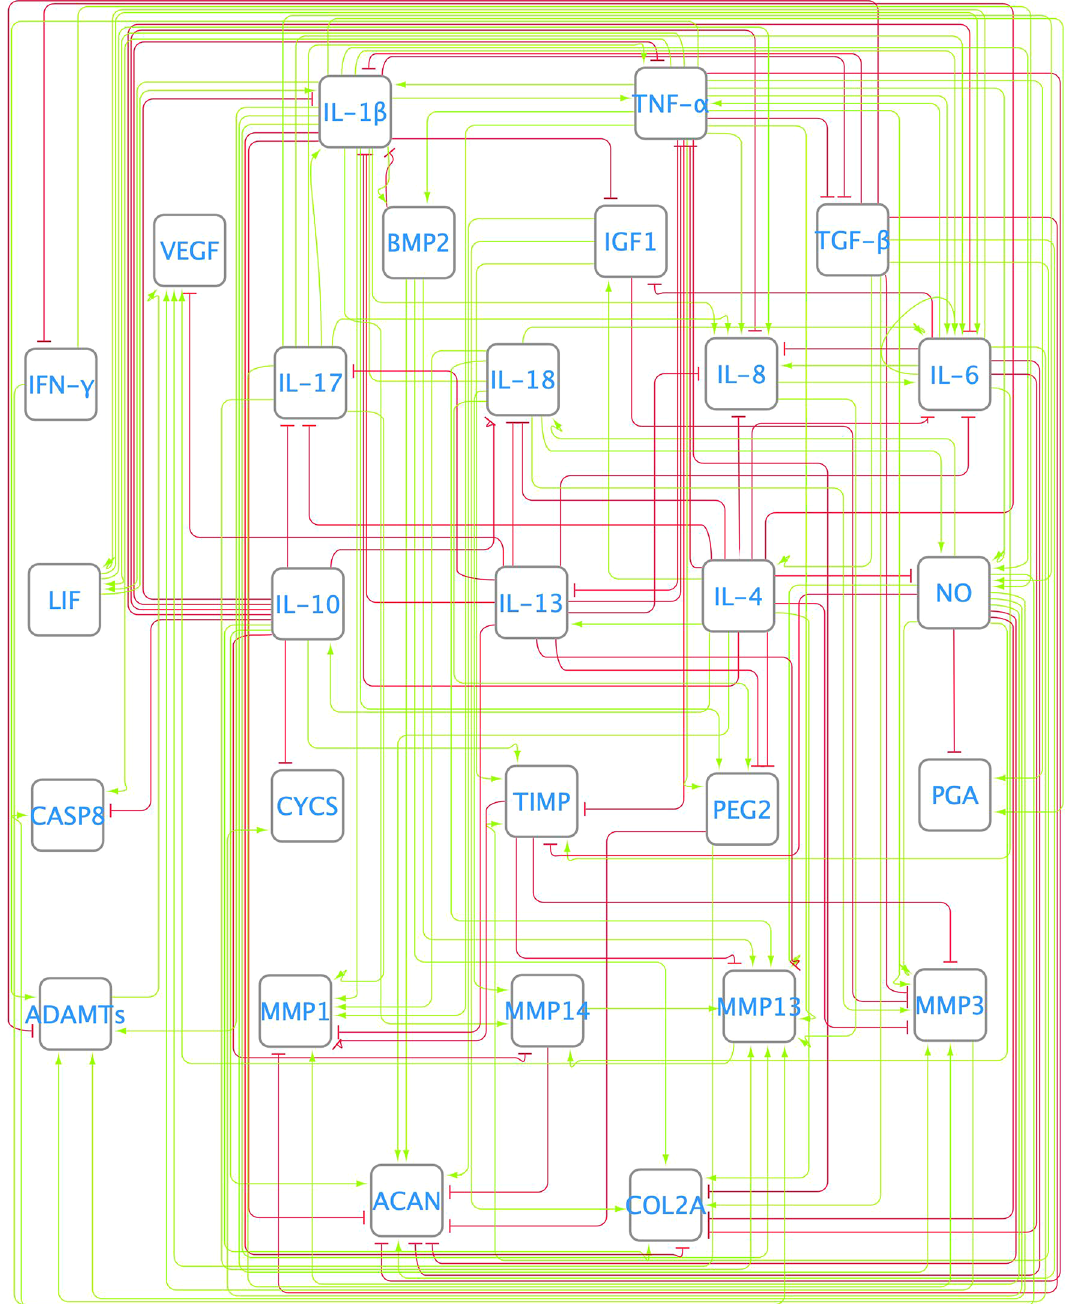
Figure 4. Enriched network (ENR). It was performed with the help of a protein–protein public database STRING 21 . The summarized connectivity can be seen in Additional Material 1 A1 Table